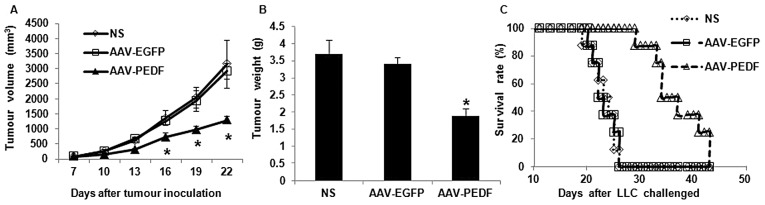
Antitumour efficacy of AAV-PEDF in vivo. (A) LLC cells were inoculated into C57BL/6 mice. When the average tumour size reached 90–100 mm3, the mice received an intratumoural injection of AAV-PEDF, AAV-EGFP or normal saline (NS). Tumour volumes were measured and calculated. (B) Mice were sacrificed on Day 15 after LLC inoculation and tumours were weighed. (C) Survival curves of mice. Significant increases in survival rates and prolonged survival times were observed in AAV-PEDF-treated mice. N=8 per group. *P<0.05 compared to AAV-EGFP or the NS control groups.